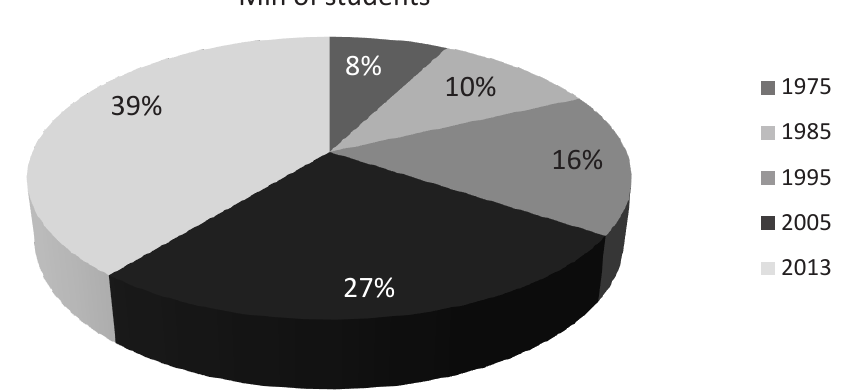
Figure 1. Mobility patterns of foreign and international students (2015)